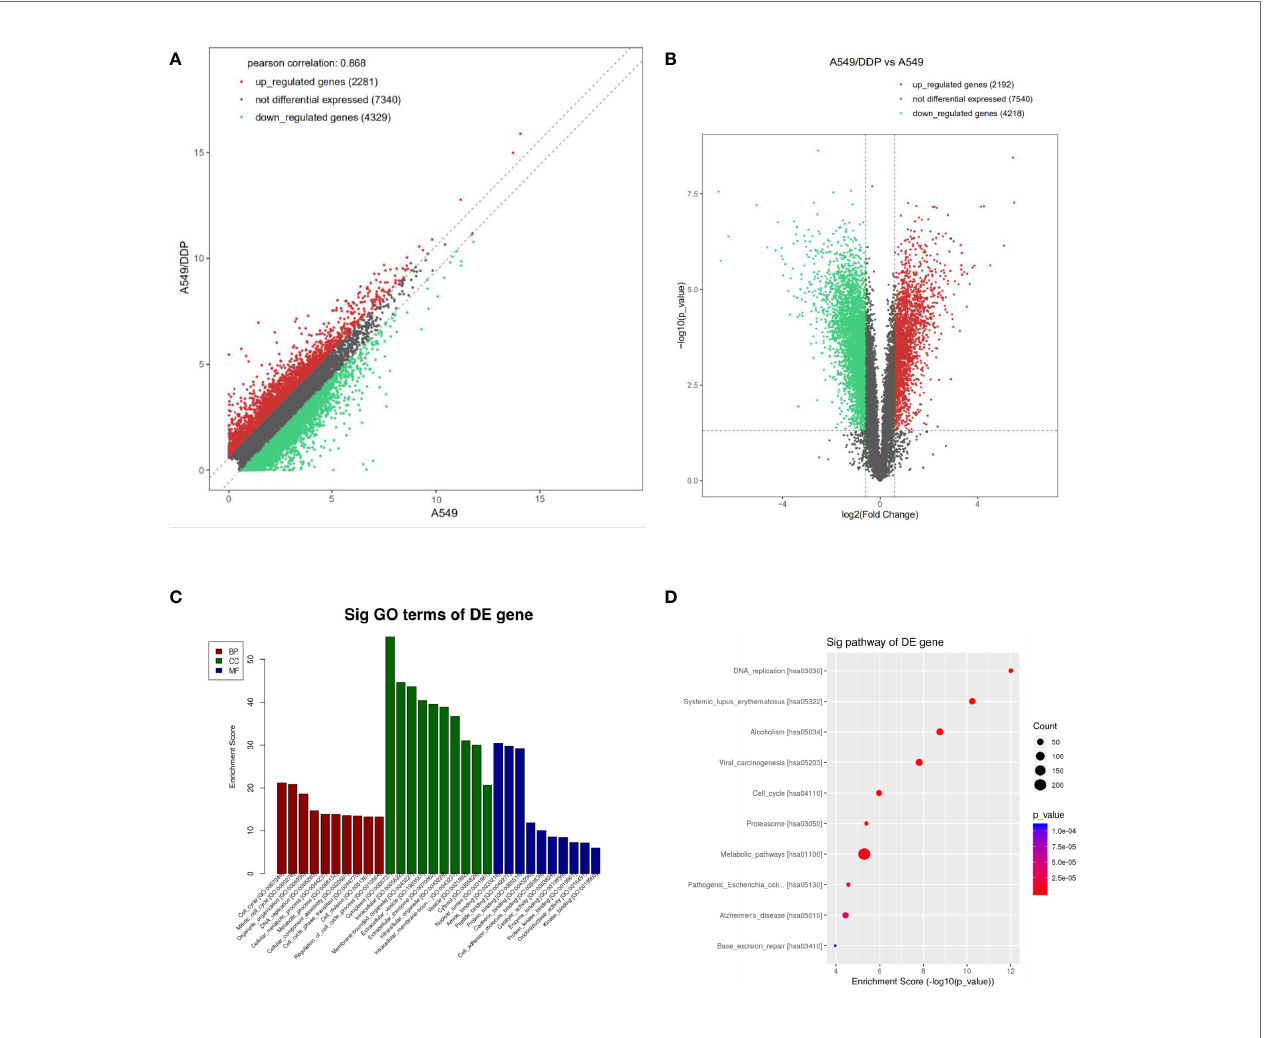
FIGURE 2 | Differential expression and enrichment analysis of mRNA in A549 cells and A549/DDP cells. The mRNA levels of A549 and A549/DDP cells were calculated by (A) scatter plot and (B) volcano plot, respectively. The red dots represent the up-regulated mRNAs in A549/DDP cells, the green dots represent the down-regulated mRNAs in A549/DDP cells, and the gray dots represent the unchanged mRNAs. (C) GO and (D) KEGG were used for enrichment analysis of differentially expressed mRNAs in A549 and A549/DDP